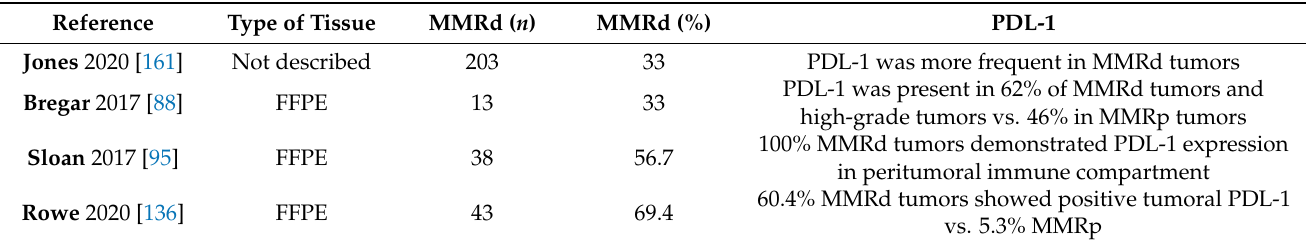
Table 6. PDL-1 in MMRd tumors in endometrial